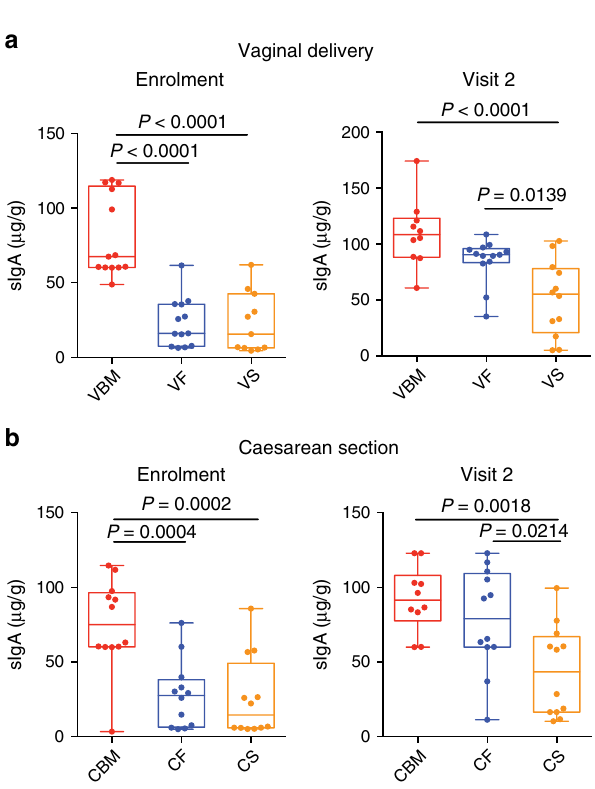
Fig. 2 Fermented formula drives sIgA production similarly to breastfeeding. a , b sIgA levels according to mode of delivery (vaginal in a and caesarean section in b ) and type of feeding were determined in faecal samples. n = 13 (VBM and VF) and n = 12 (VS, CBM, CS and CF) biologically independent samples. Signi fi cance determined by one-way ANOVA using TukeyHSD post hoc test. Box plots show the interquartile range (IQR), the horizontal lines show the median values and the whiskers indicate the minimum-to- maximum range. CBM caesarean delivery breast milk feeding, CF caesarean delivery fermented formula feeding, CS caesarean delivery standard formula feeding, VBM vaginal-delivery breast milk feeding, VF vaginal- delivery fermented formula feeding, VS vaginal-delivery standard formula feeding. Source data are provided as a Source Data fi (Supplementary Fig. 3, Supplementary Table 2). Moreover, Clostridium innocuum was enriched in formula S-fed infants, irrespective of the mode of delivery, while Veillonella was reduced in formula-fed as compared with breastfed infants ’ s microbiota, irrespective of the mode of delivery (Supplementary Table 3). T